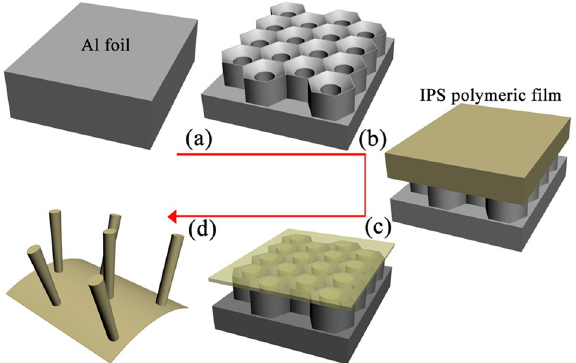
Figure 1. Schematic of fabrication procedure of polymeric nanowire. ( a ) A two-step anodization process, ( b ) Transfer of polymer film onto AAO template after AAO pore-widening and anti-adhesion pretreatment, ( c ) The thermal NIL process. ( d ) Removal of AAO template from polymeric film.